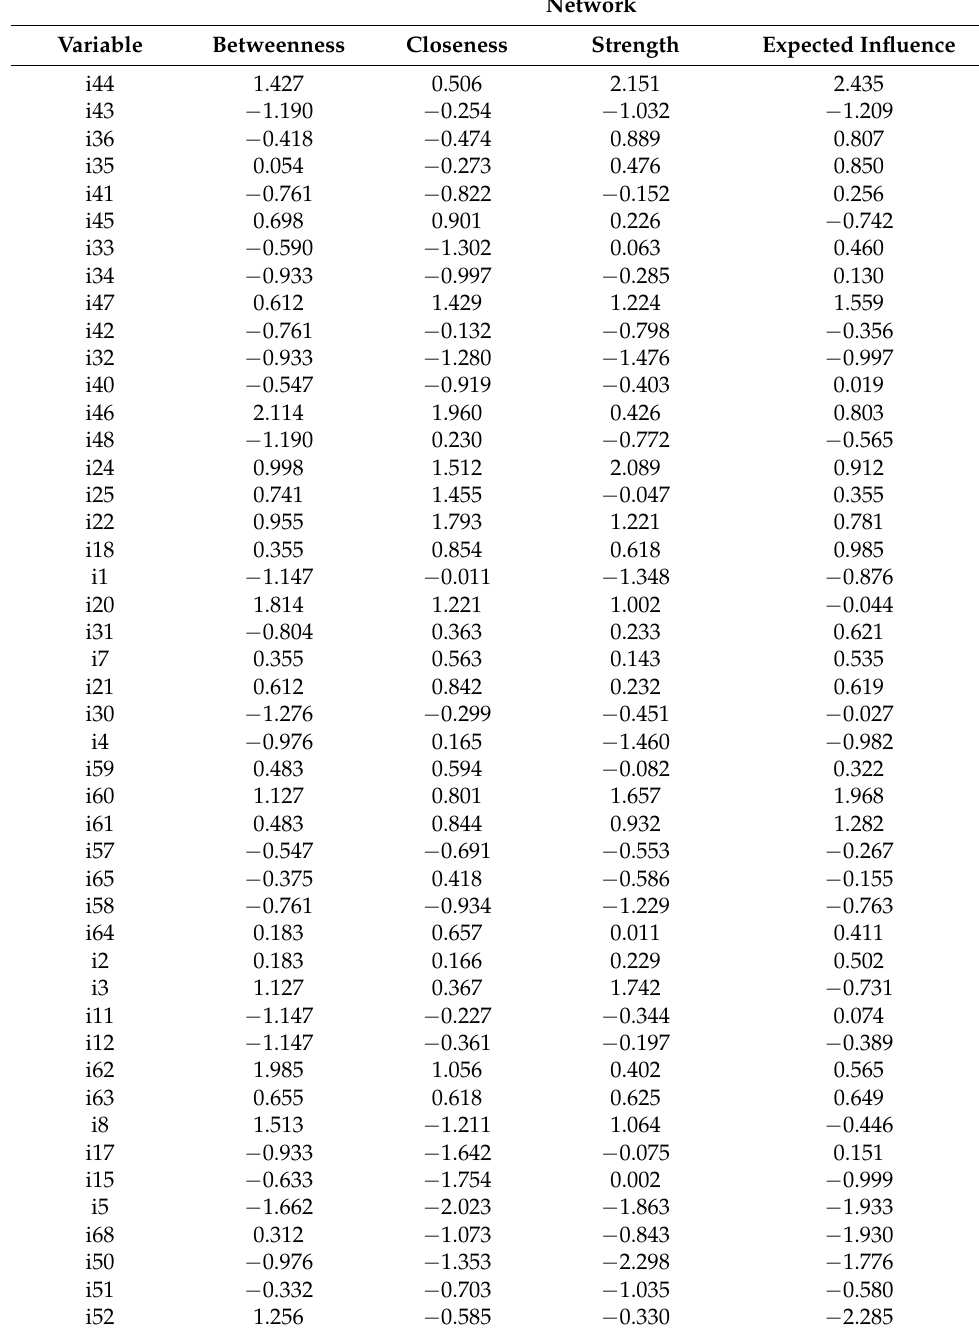
Table 4. Centrality measures per